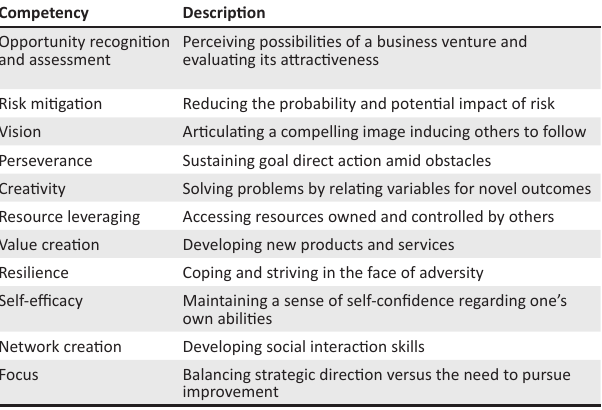
TABLE 2: Competencies necessary for entrepreneurial behaviour.